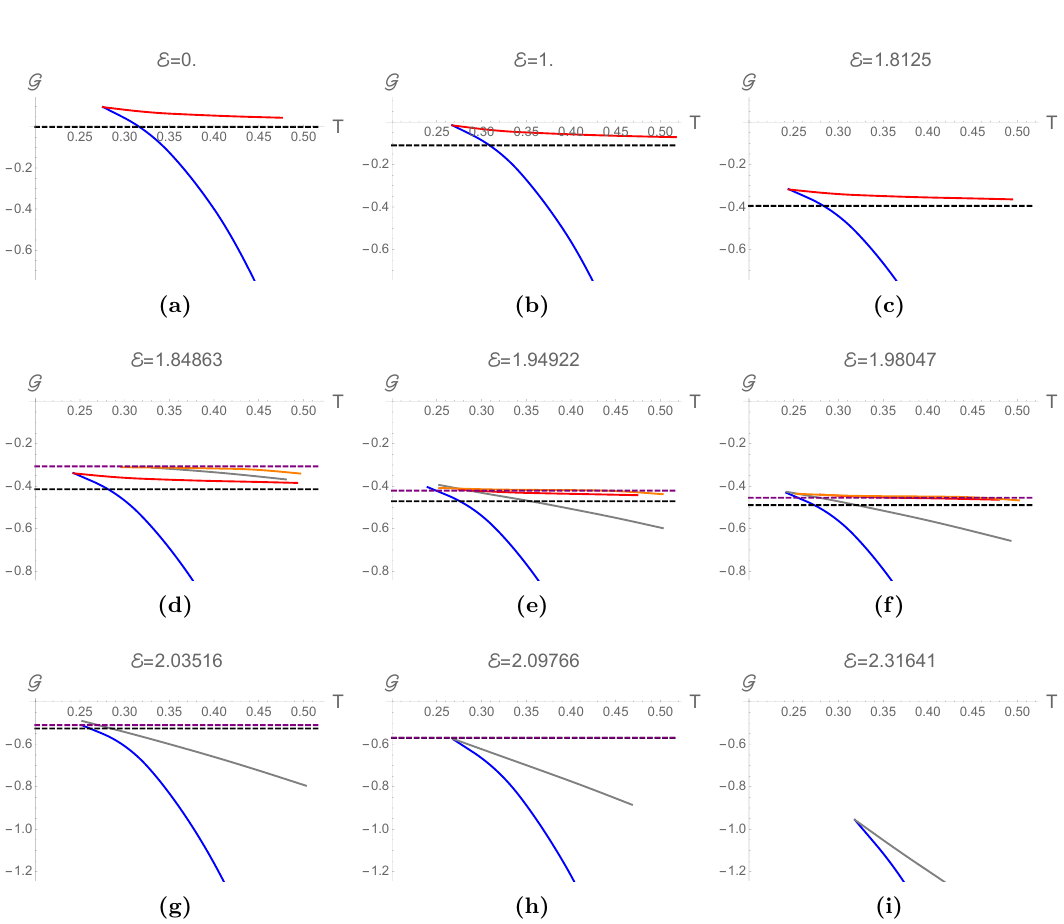
Figure 17. Gibbs free energy for L1, L2, S1, and S2 black hole branches (blue, gray, red, and orange curves), and AdS soliton (black and purple dashed line) for several values of the electric (cid:12)eld as a function of the temperature. In these plots we set G N =